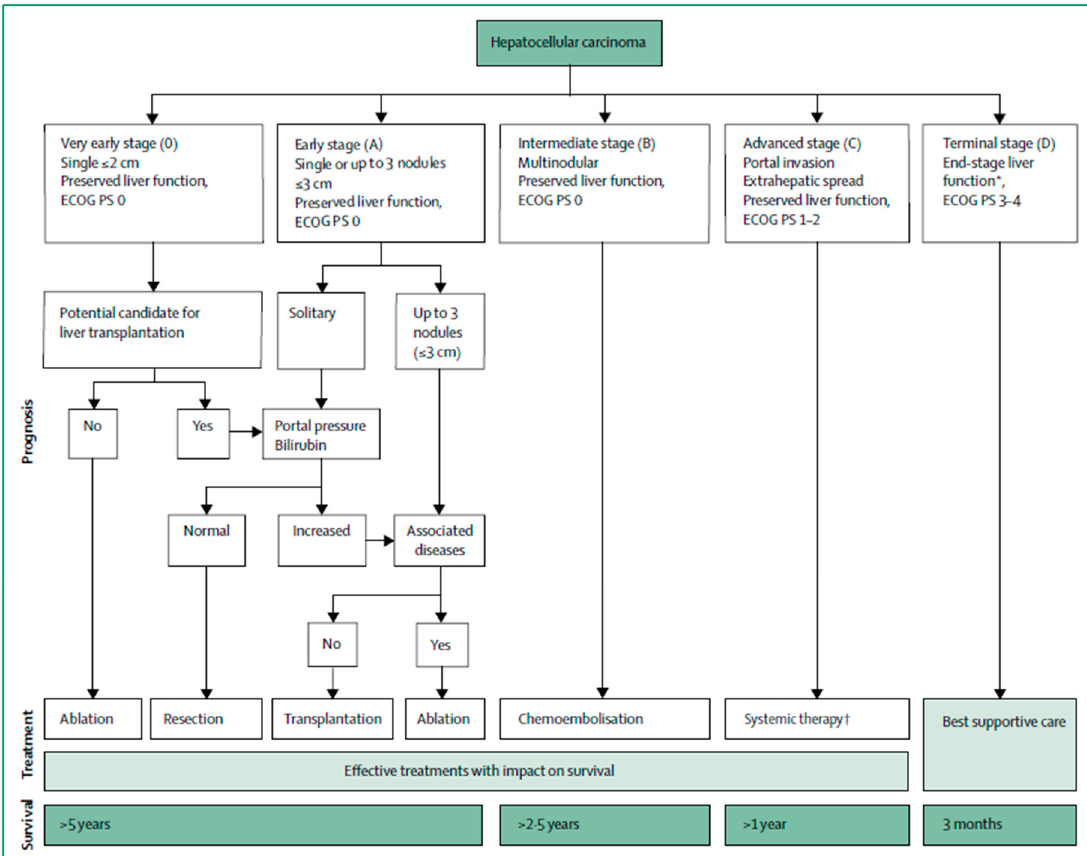
Figure 1. Barcelona Clinic Liver Cancer (BCLC) staging system and treatment algorithm The BCLC system provides treatment strategy in addition to prognostic outcomes by stage. Outcomes are expressed as median survival. ECOG PS = Eastern Cooperative Oncology Group Performance Status. * Patients with end-stage cirrhosis (i.e., Child-Pugh stage C, poor prognosis, or high Model for End-Stage Liver Disease (MELD) score). † First-line treatment with sorafenib or lenvatinib. Reproduced with permission from [6].